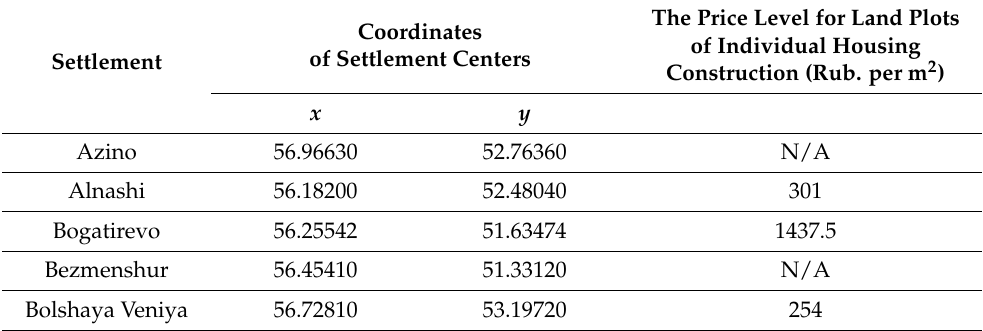
Table 5. Basic data for grouping settlements by spatial and price characteristics